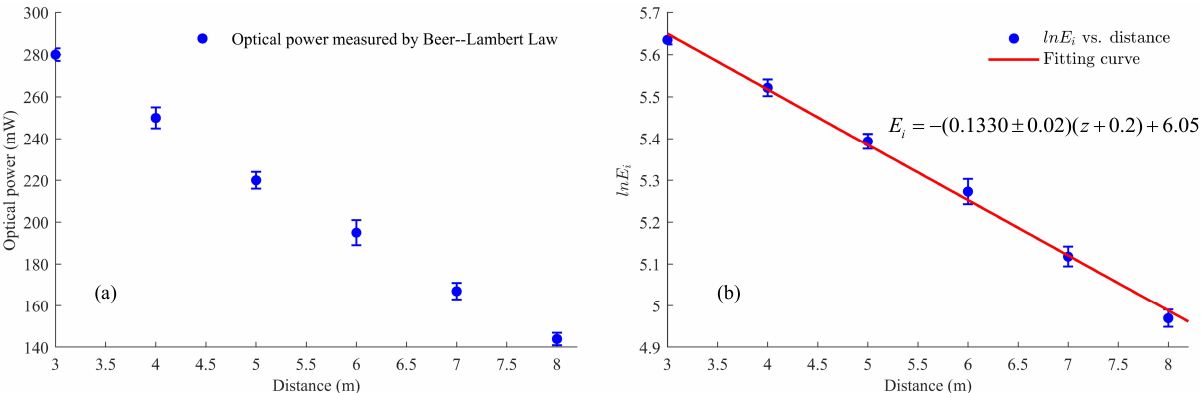
Figure 4. ( a ) Averaged optical power for five measurements after 3–8 m propagating distances in fresh water. ( b ) Fitting curve based on Beer–Lambert law; the coefficient of determination was